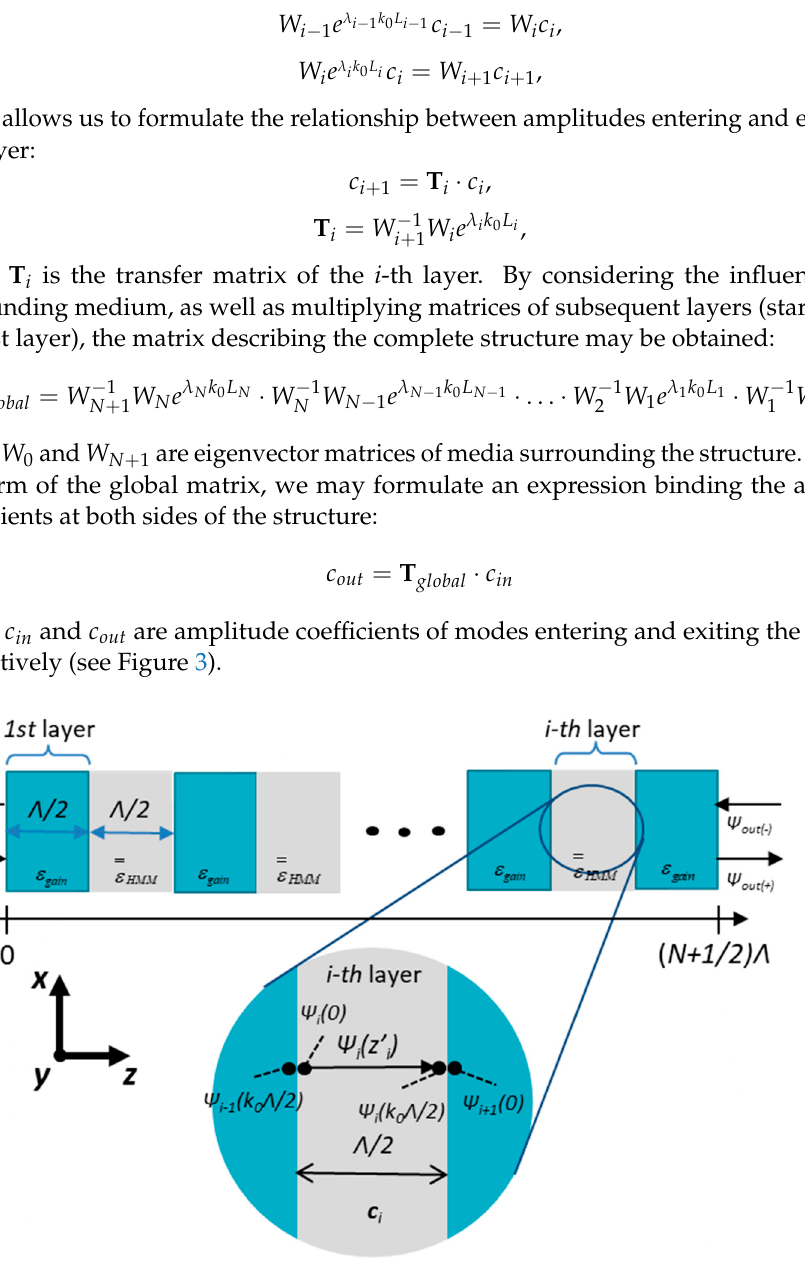
Figure 3. Schematic of the considered PHC structure in transfer matrix method analysis.